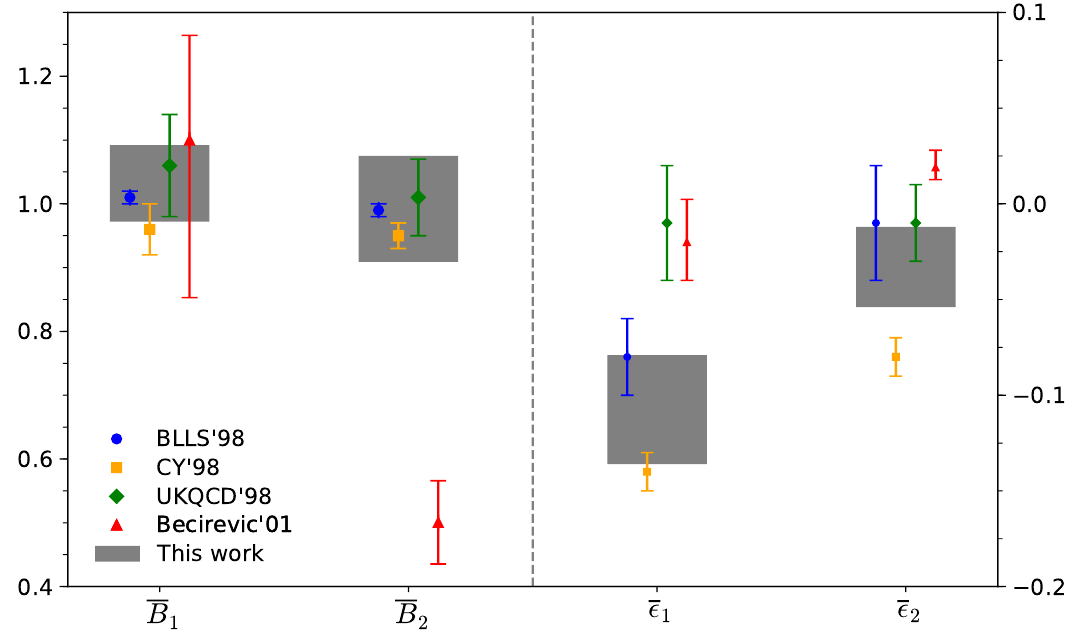
Figure 6 . Comparison of our results for the (cid:1) B = 0 Bag parameters at the scale m b ( m b ) to the HQET sum rule results BLLS’98 [14] and CY’98 [15], and the lattice values of UKQCD’98 [22] and Becirevic’01